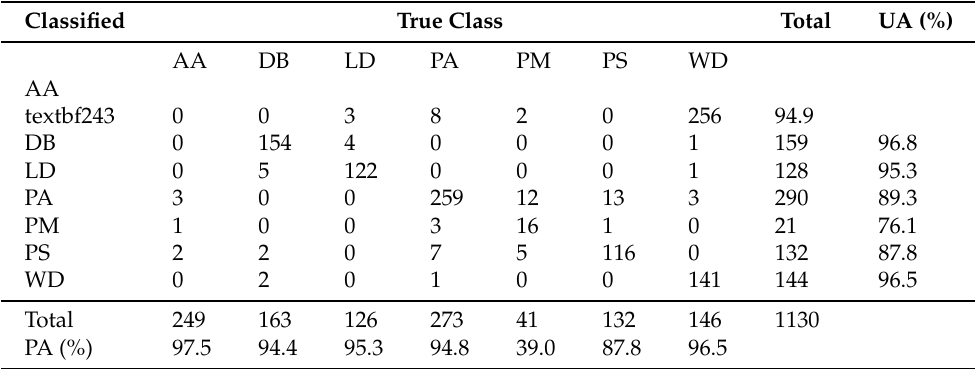
Table 4. Confusion matrix for all tree classes of the classification key based on reference data; OA: 92.8%.